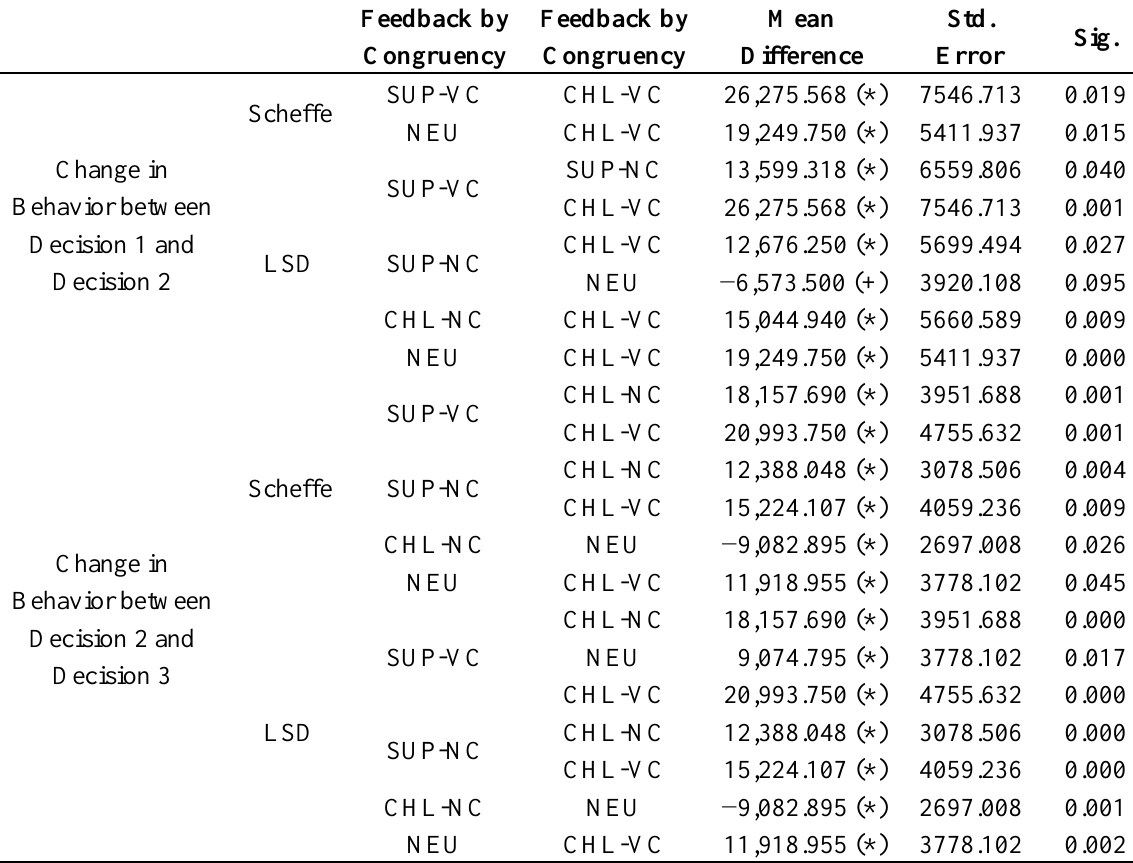
Table 8. Significant Paired Comparisons for Change between Decisions by Value Congruency or